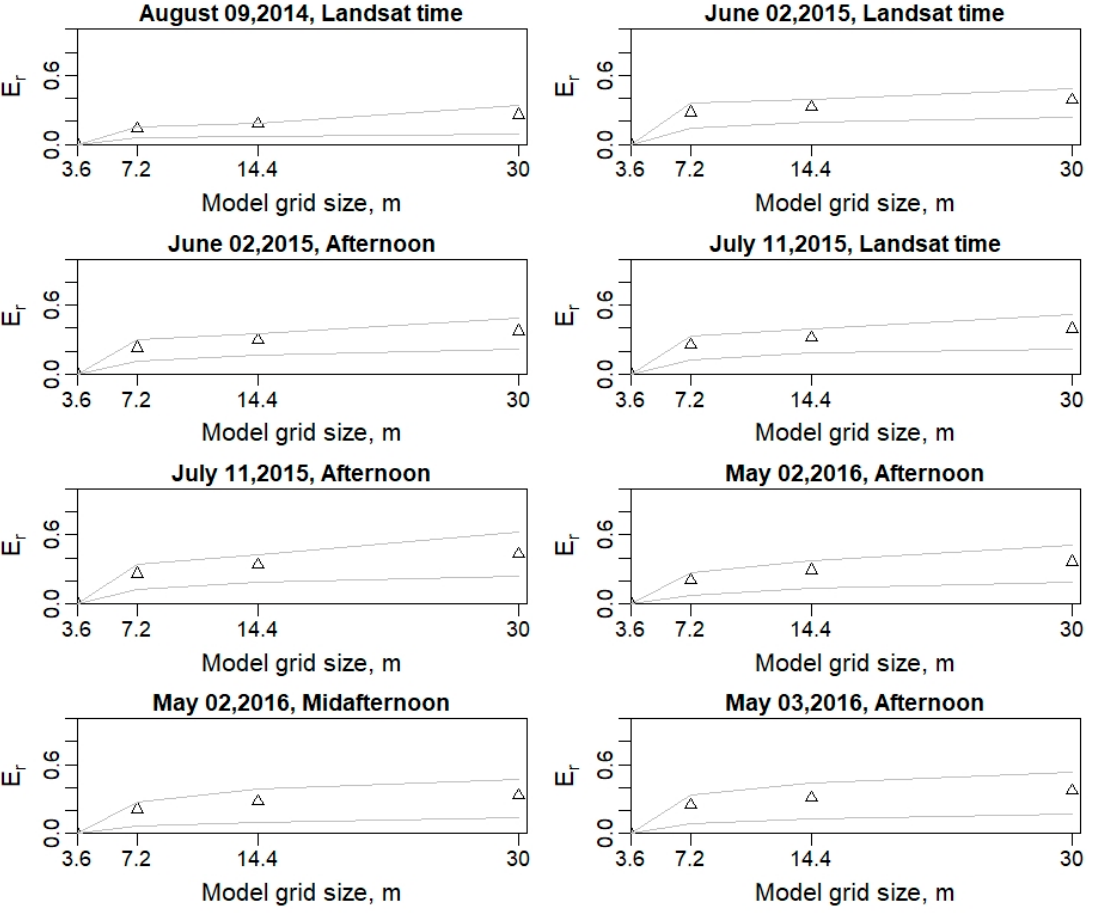
Figure 16. Relative error ( E r ) at different spatial resolutions for LE with the triangle symbols indicating mean and light lines indicating the 25th and 75th percentiles for the coarse grid sizes.